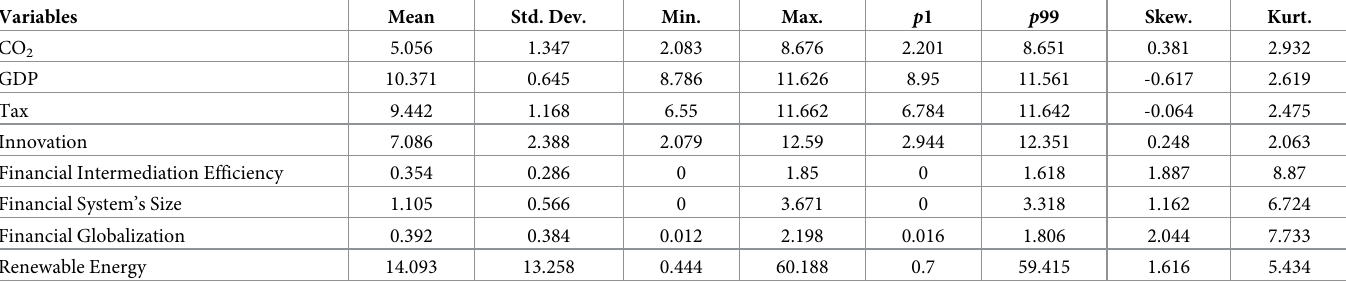
Table 1. Descriptive statistics.